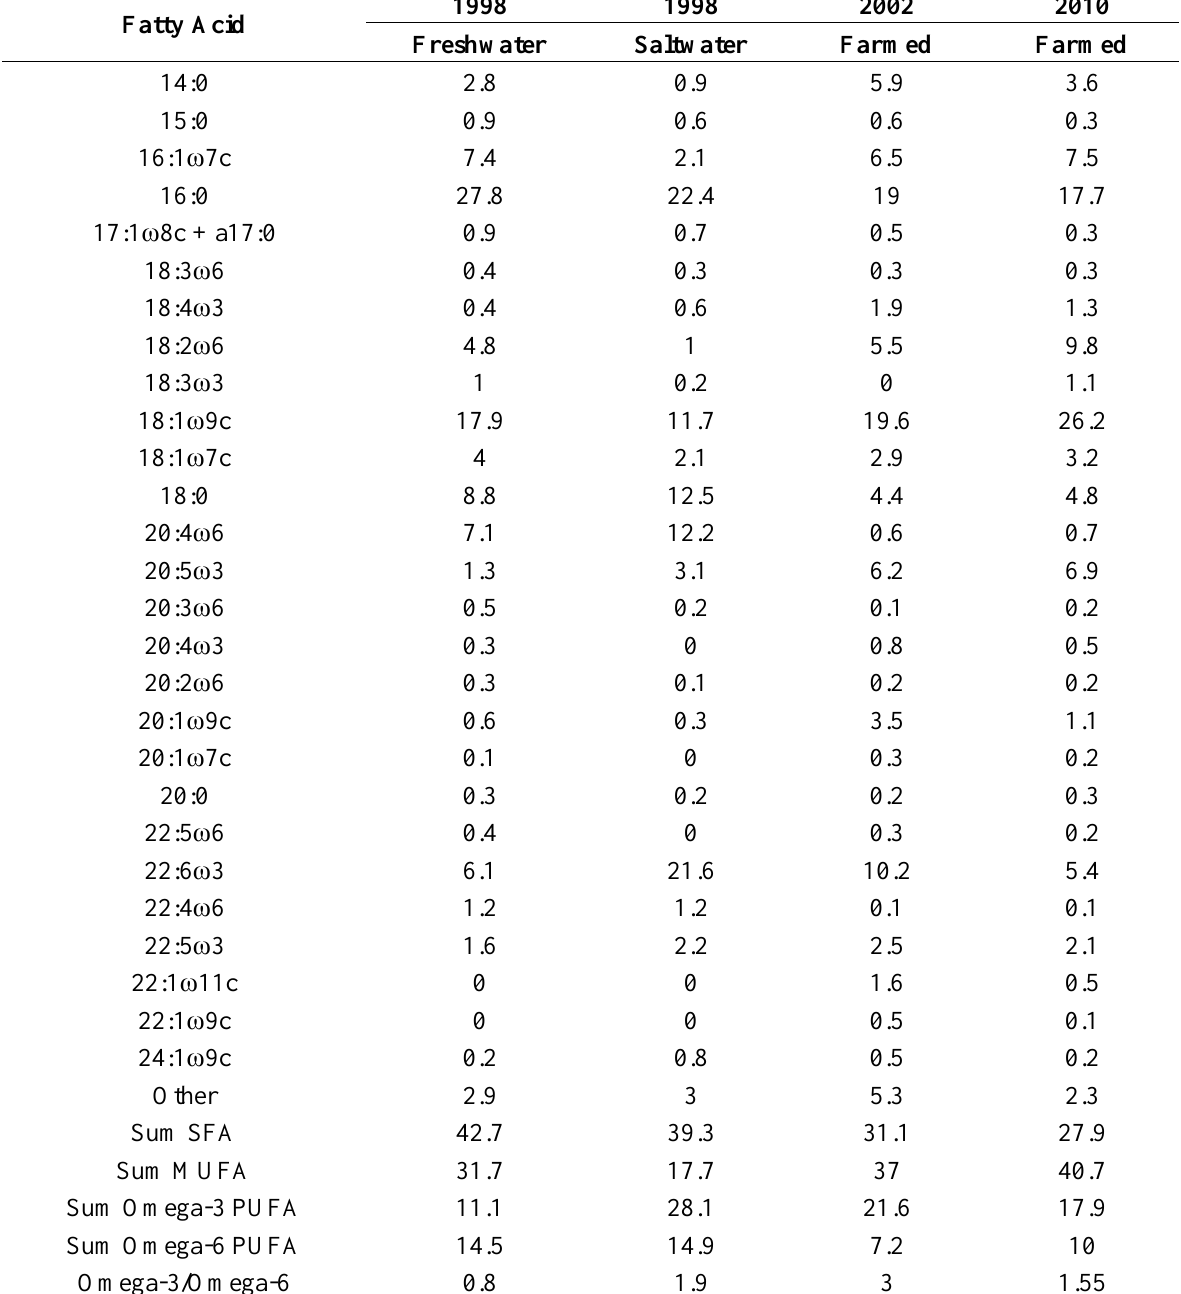
Table 2. Composition of fatty acids (as percent of total FA) in wild and farmed barramundi. Fatty